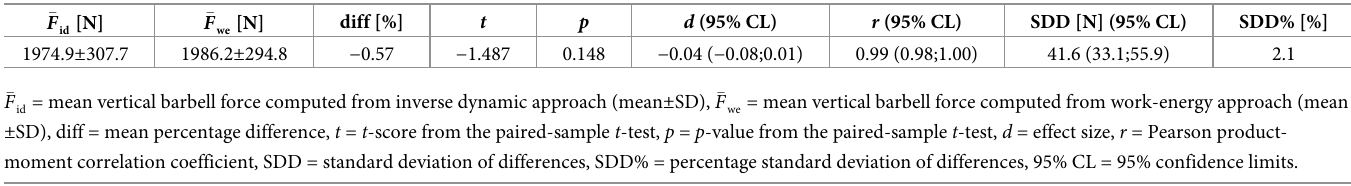
The results of the Deming regression did not reveal a constant bias (i.e., confidence limits of intercept contained the value 0) or proportional bias (i.e., confidence limits of slope con-